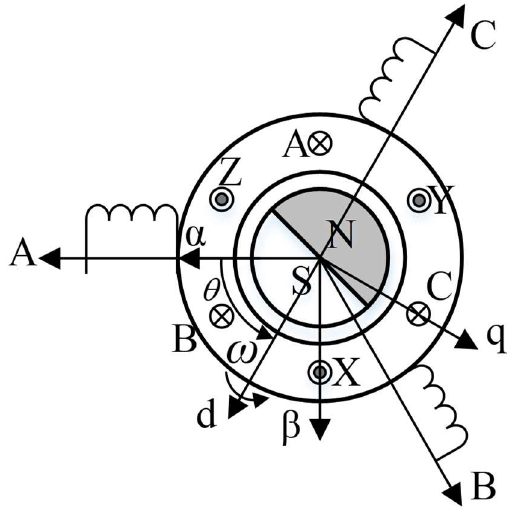
Figure 1. Model of permanent magnet synchronous motors (PMSM).